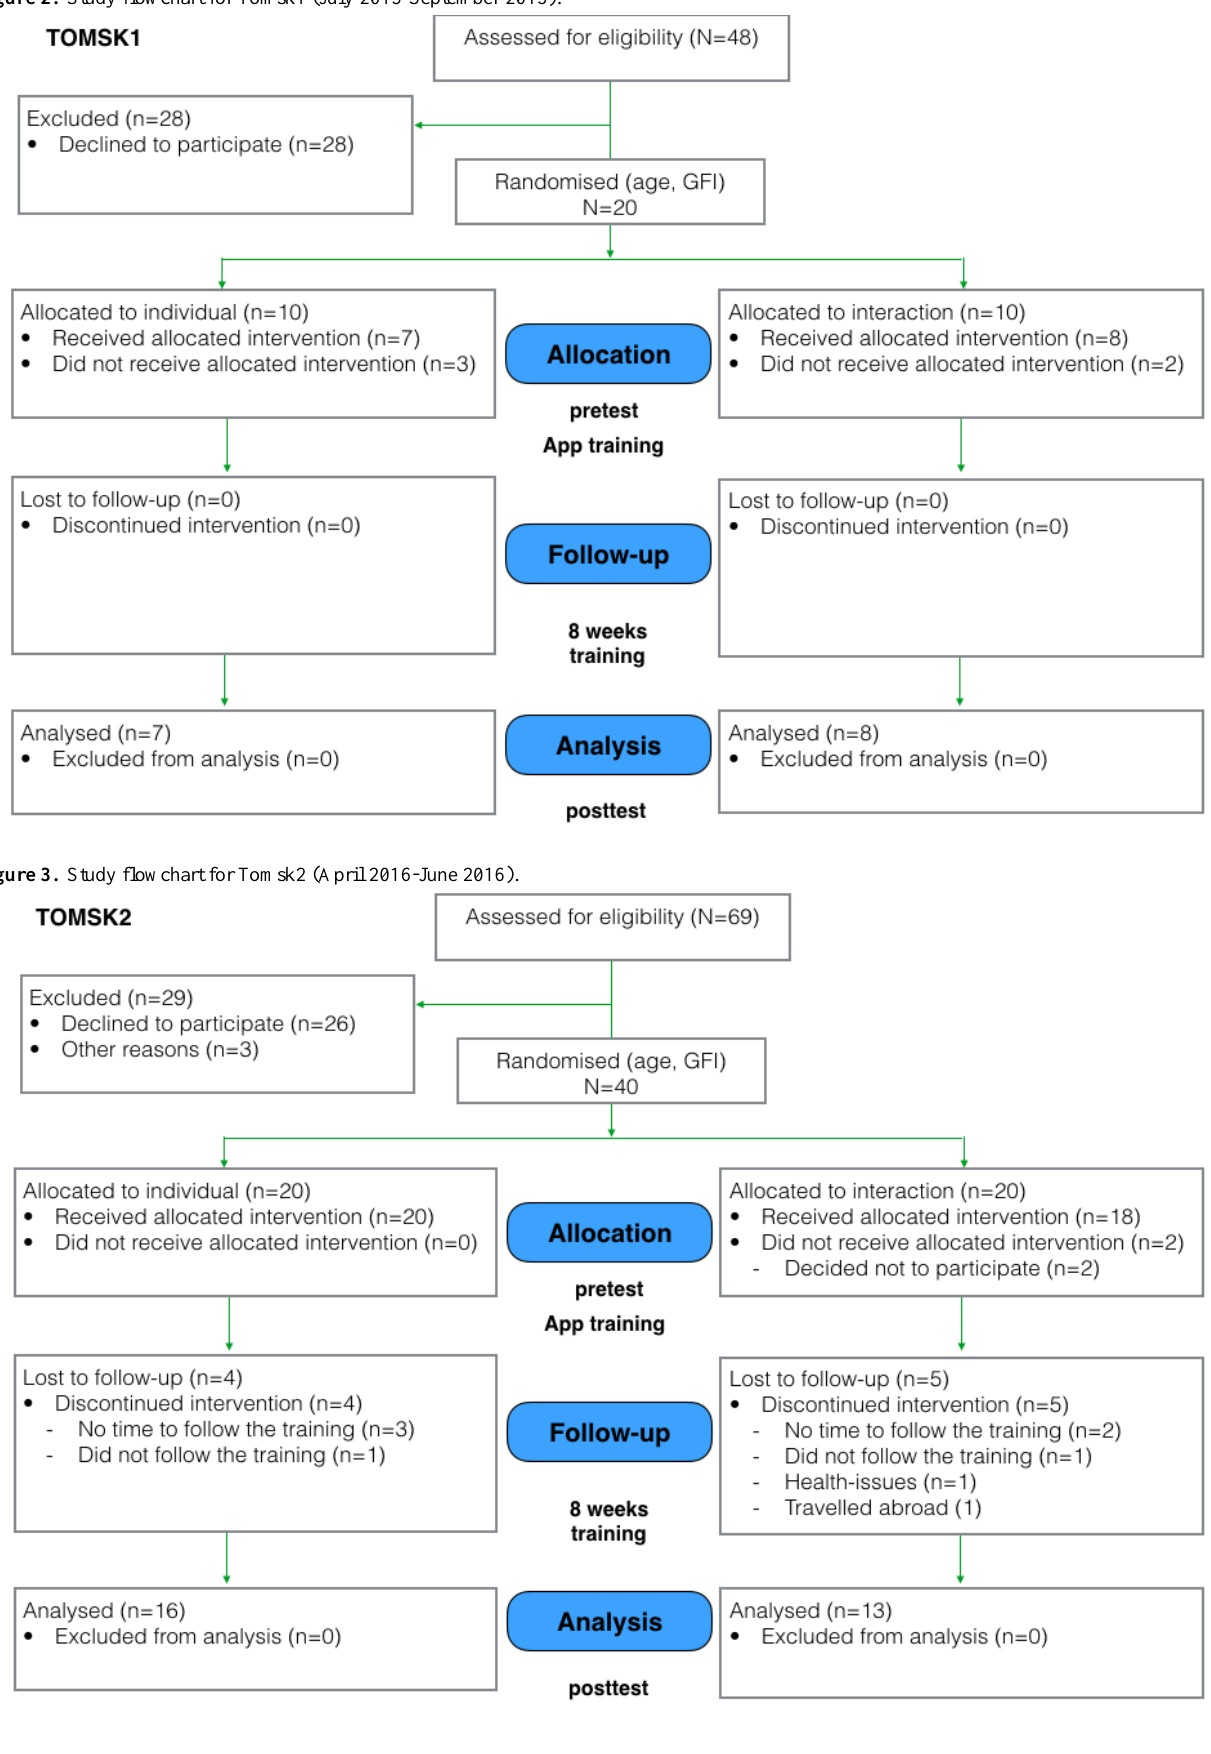
Figure 2. Study flowchart for Tomsk1 (July 2015-September 2015).